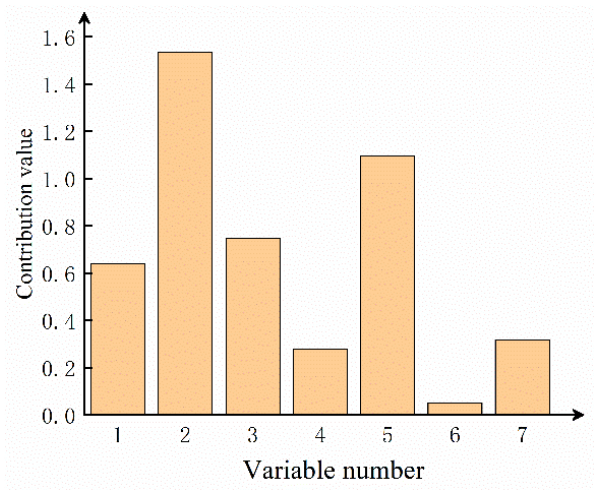
Figure 17. Relative contribution plot of sample 1.